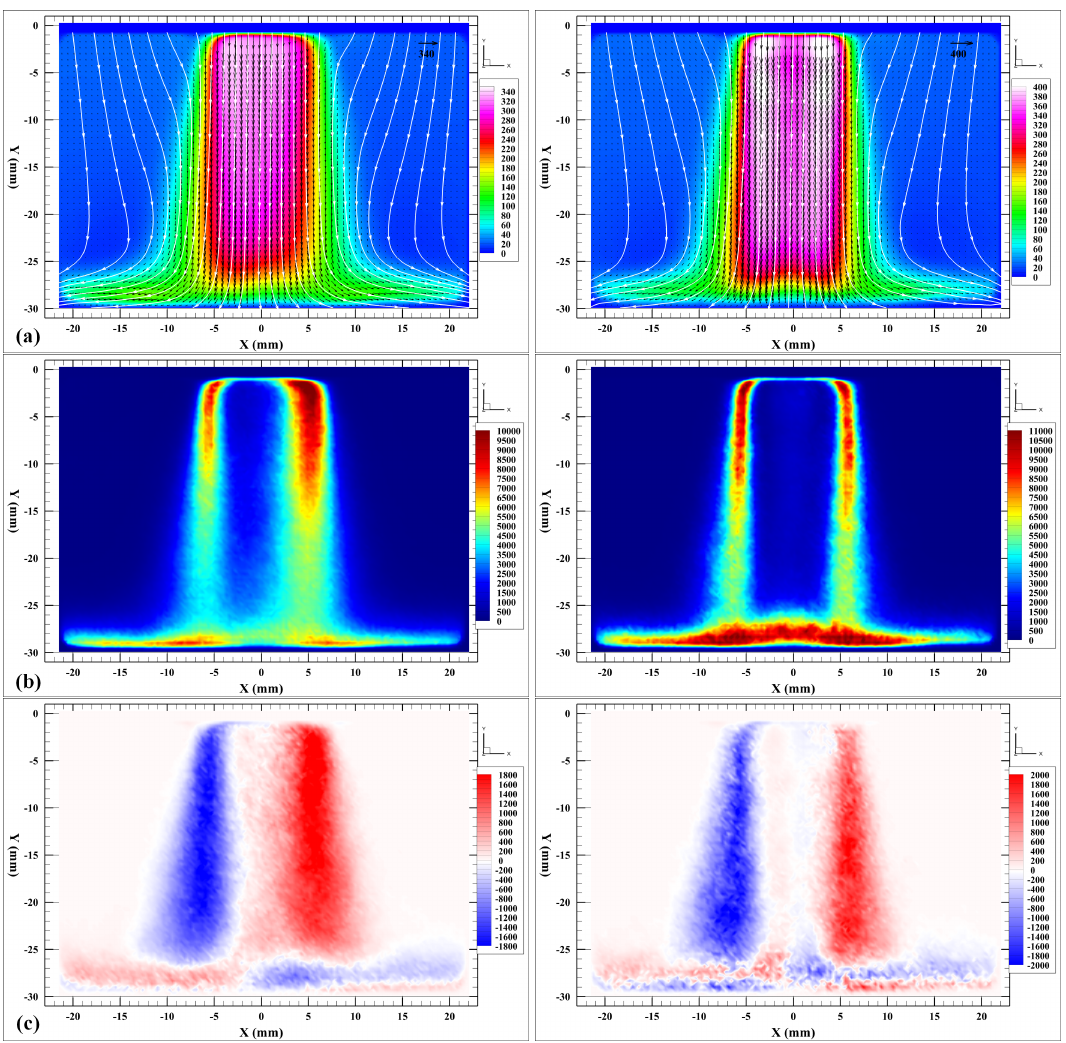
Figure 4. PIV results obtained from experimental measurements of under-expanded impinging jets with the nozzle-to-plate e = 30 mm ( e / D j = 2.46) and at NPR 2 = 2.2 (left) and NPR 4 = 2.77 (right). ( a ) Mean in-plane velocity fields, color contour of velocity magnitude (m/s) and velocity streamlines, color contours of ( b ) turbulent kinetic energy k (m 2 /s 2 ), and ( c ) Reynolds stress (cid:104) u (cid:48) v (cid:48) (cid:105) (m 2 /s 2 ). Vectors were de-sampled for better